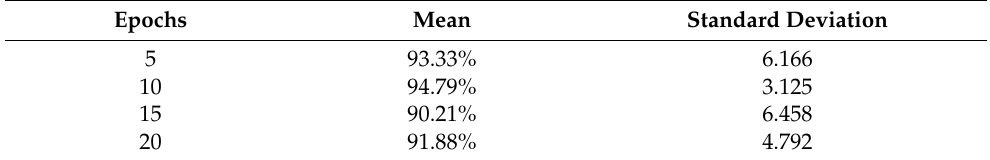
Table 7. Performance of the RNN model.